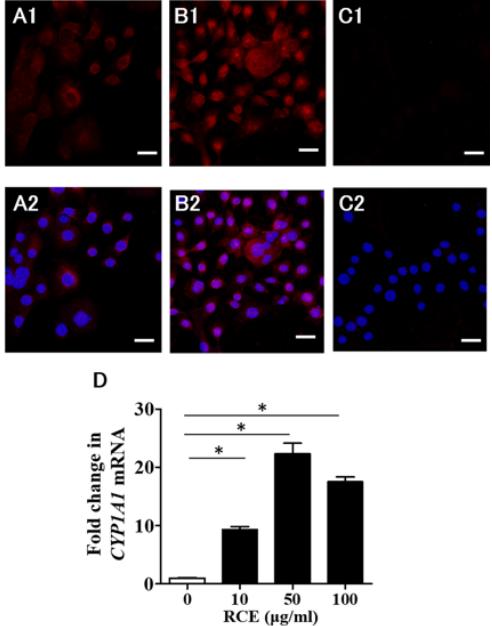
Figure 1. Immunolocalization of an aryl hydrocarbon receptor (AHR). ( A1 ) AHR is mainly localized in the cytoplasm in keratinocytes treated with dimethyl sulfoxide (DMSO) control; ( A2 ) Nuclear 4 ′ ,6 ‐ diamidino ‐ 2 ‐ phenylindole (DAPI) staining of A1; ( B1 ) Nuclear translocation of AHR is observed in keratinocytes treated with 100 μ g/mL Rhodiola crenulata extract (RCE); ( B2 ) Nuclear DAPI staining of B1; ( C1 ) Isotype ‐ matched negative control showed no positive staining; ( C2 ) Nuclear DAPI staining of C1. Scale bar: 25 μ m; ( D ) RCE increases the expression of CYP1A1 . White bar expresses DMSO control. Data are expressed as mean ± SEM ( n = 3). *: p < 0.05.